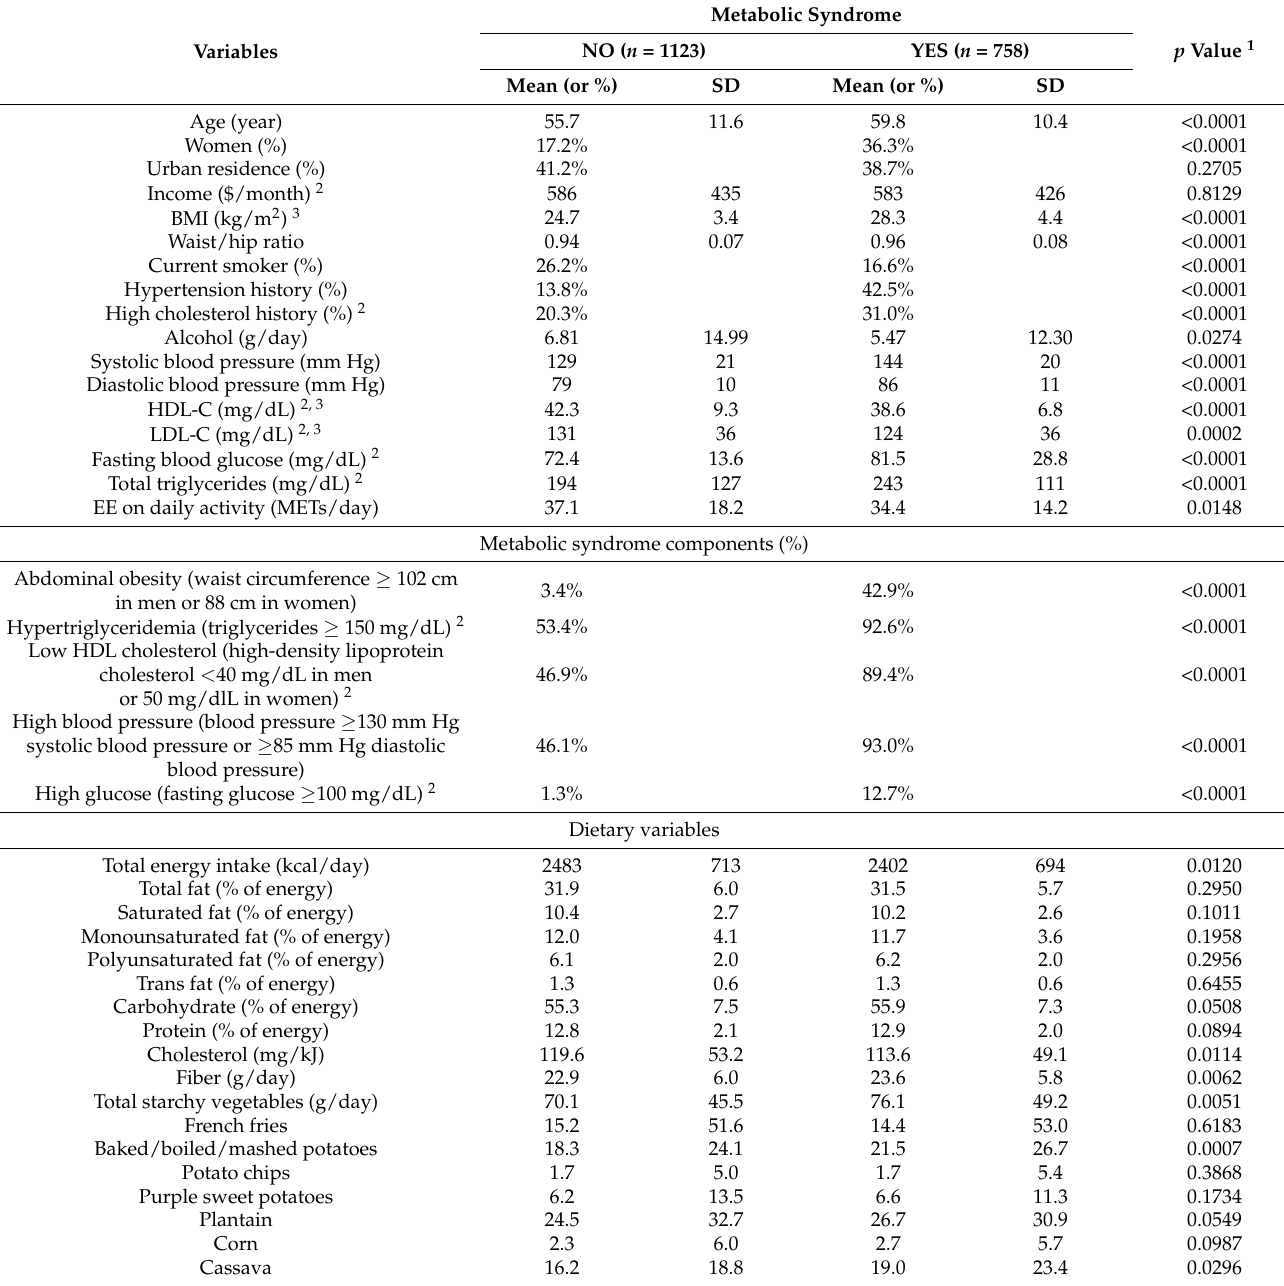
1.02, P for trend: 0.8926). For total starchy vegetables and healthy starchy vegetables, a higher consumption was associated with lower fasting blood glucose in the fully adjusted models (P total starchy for trend: 0.0040, P healthy starchy for trend: 0.0236, respectively). The dif- ference in glucose concentrations between the lowest and highest quintile was 5.1 mg/dL for the total starchy vegetables and 3.5 mg/dL for the healthy starchy vegetables (Table 3). Table 1. Characteristics of the study population by metabolic syndrome status in Costa Rican adults ( n = 1881).